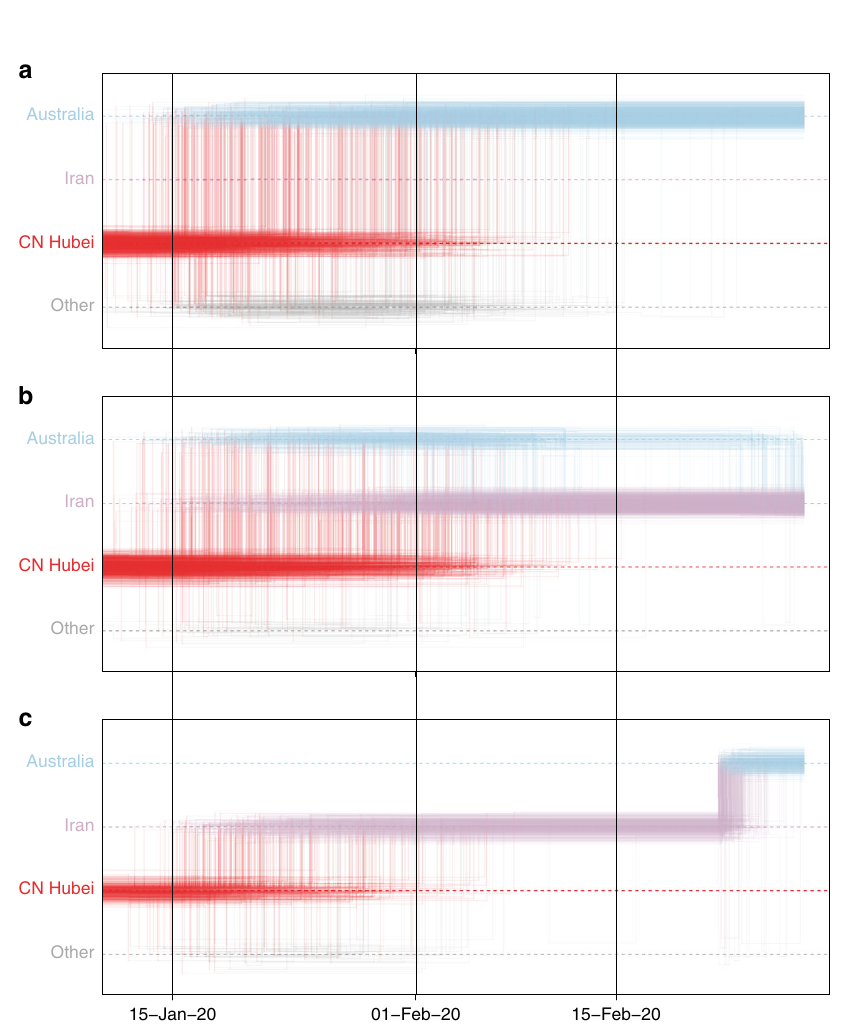
Fig. 3 Markov jump trajectory plot depicting the ancestral transition history between locations from Hubei up the sampling location for an Australian genome (EPI_ISL_412975) in lineage B.4. The reconstructions use a sampling location only, b travel origin location, and c sampling location and travel history. The trajectories are summarized from a posterior tree distribution with Markov jump history annotation in the same way as in Fig.